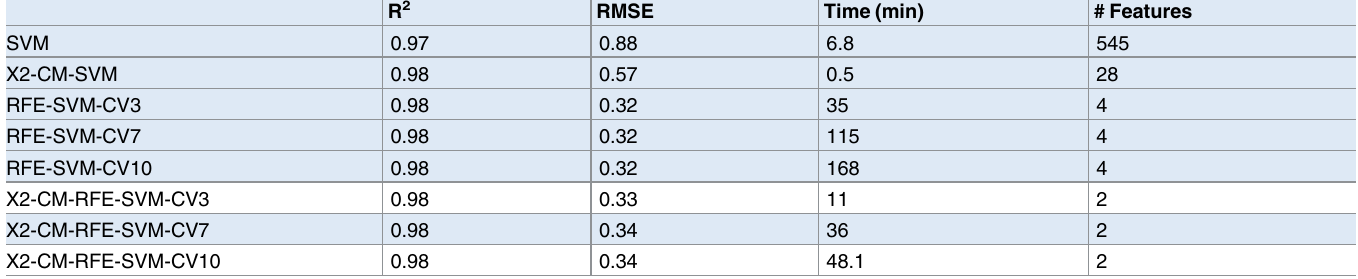
Table 1. Benchmark of the SVM regression model for Dataset2 applying different FS methods (SVM), no feature selection, (X2) univariate correla- tion alone, (CM) correlation matrix filtering, (RFE) and wrapper feature elimination. The figures indicatedusing the prefixes CV3, CV7 and CV10 corre- spondto the number of interactions in the cross-validationsteps duringthe RFE feature